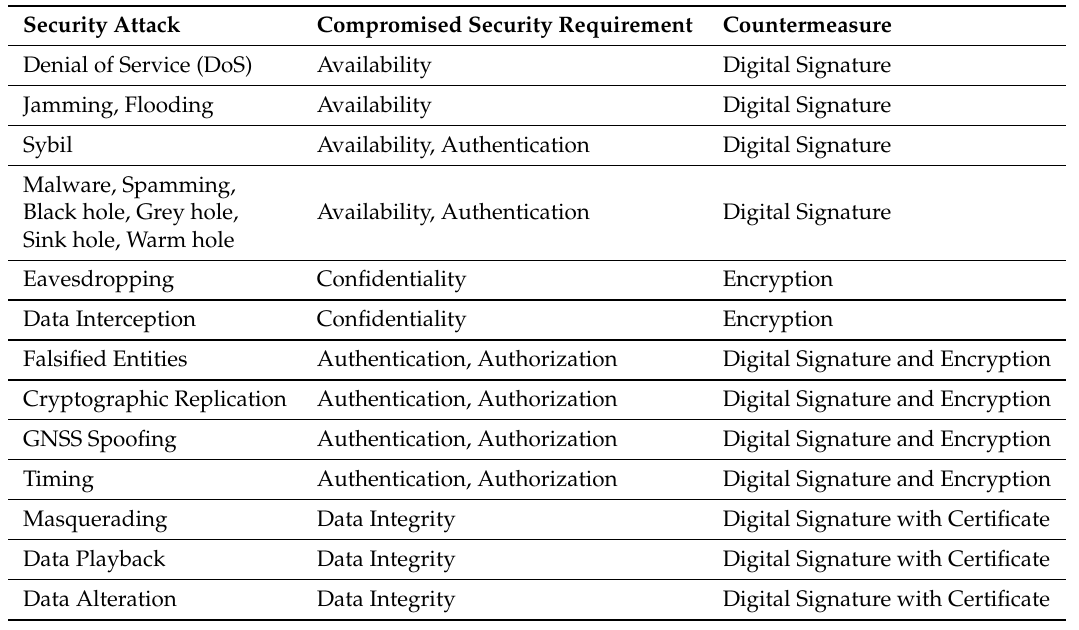
Table 1. Security attacks, compromised security requirements and